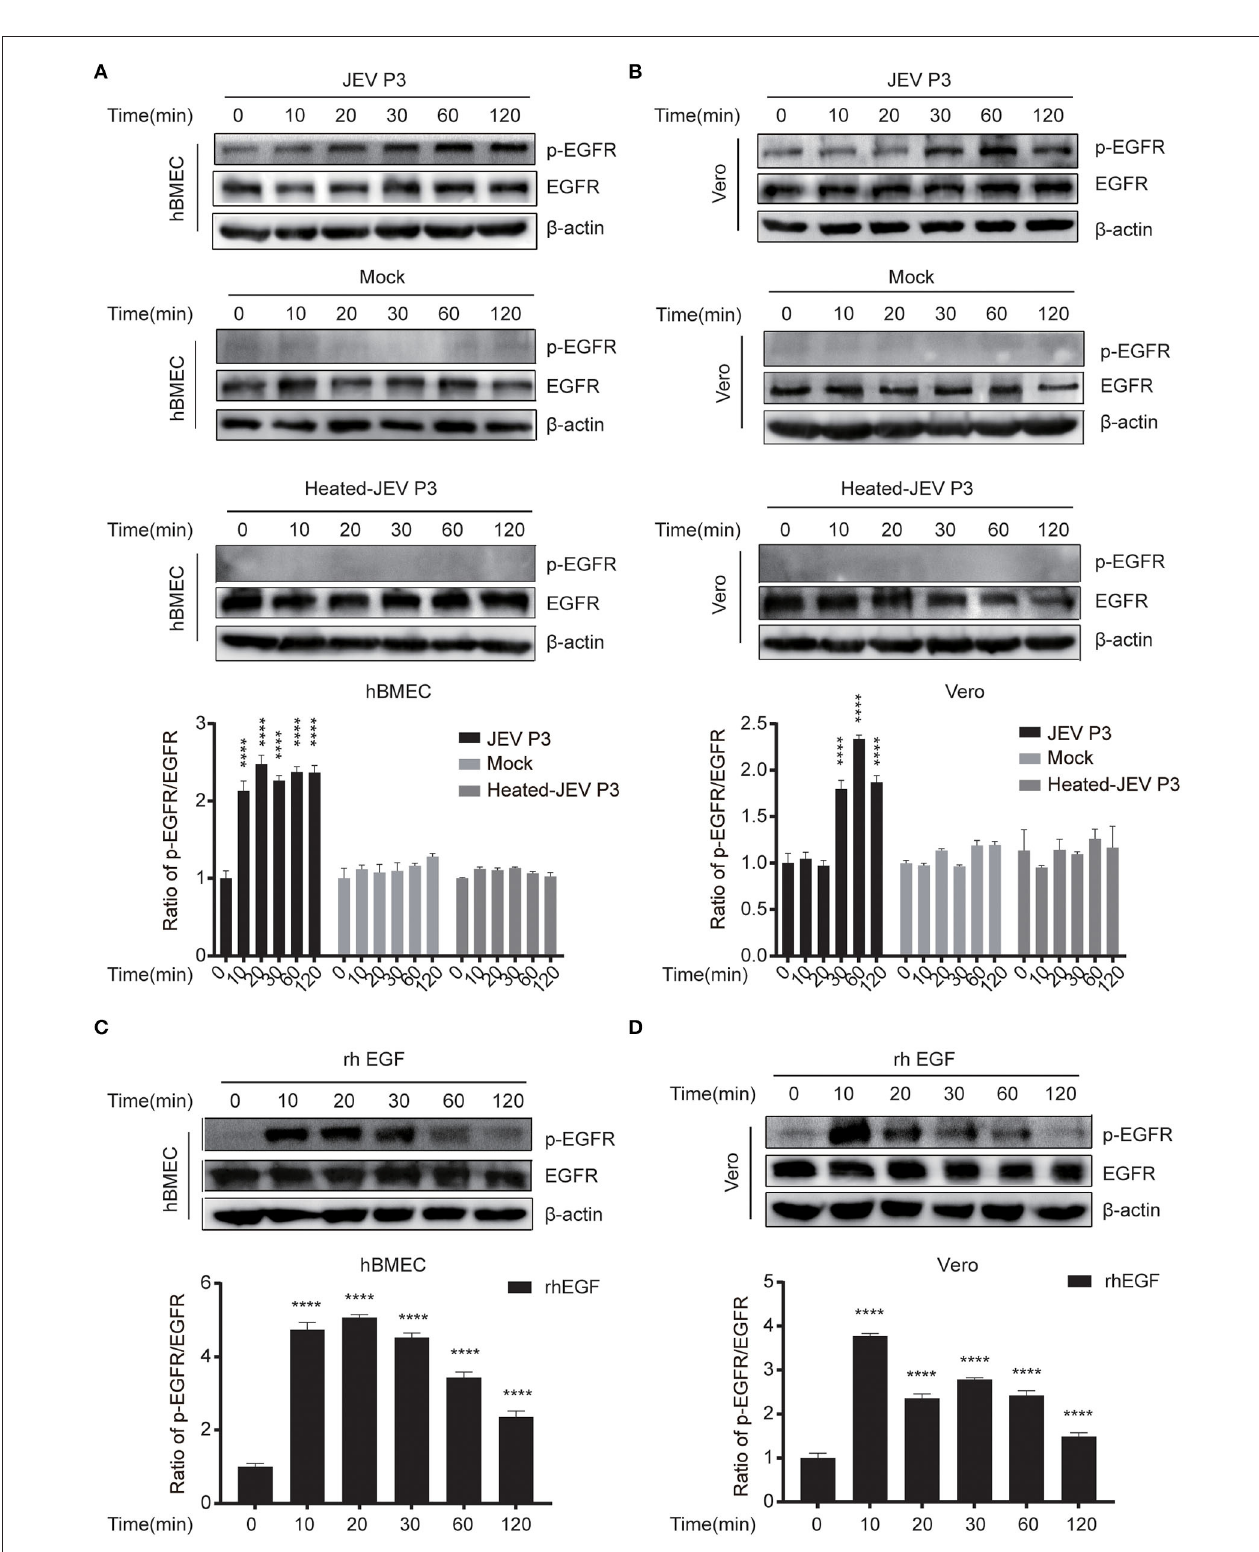
FIGURE 1 | JEV infection induces EGFR phosphorylation. (A,B) hBMECs and Vero cells were infected with JEV P3 (MOI = 1) or heated-inactivated JEV P3 (heated-JEV P3, 94 ◦ C, 15min, MOI = 1) for 0, 10, 20, 30, 60, and 120min, and the cells treated with DMEM were used as control. Cell lysates were harvested